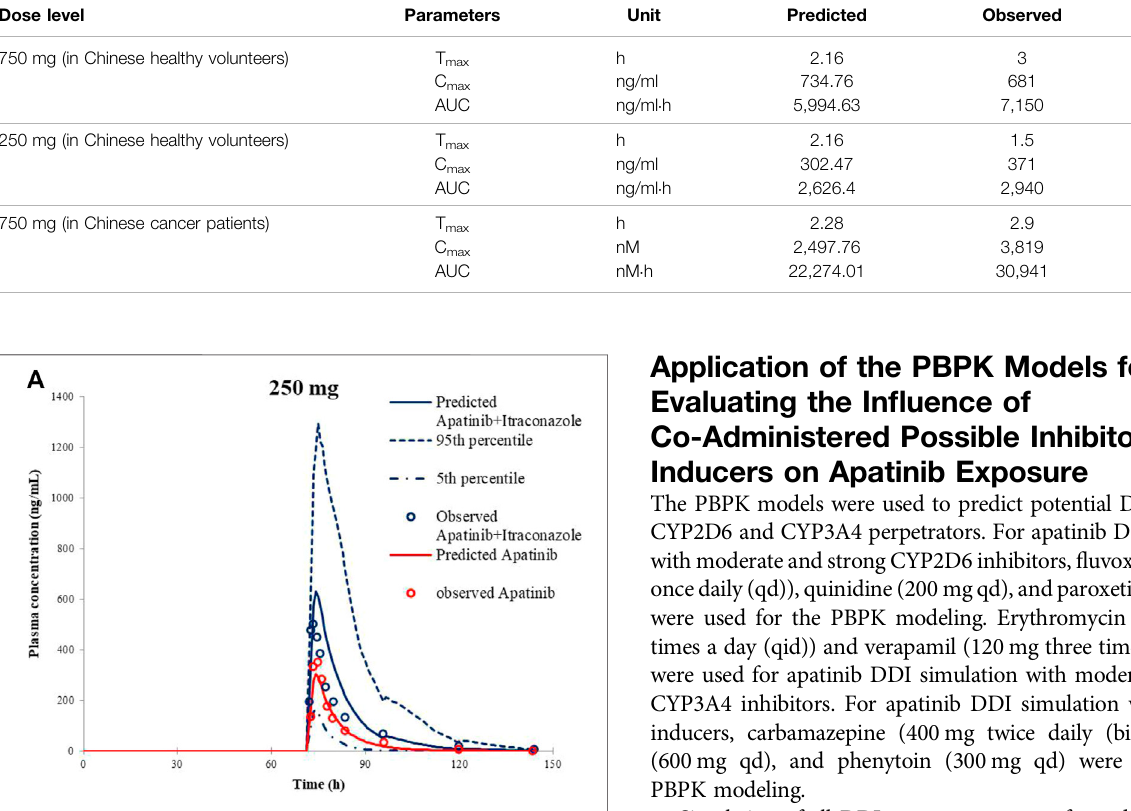
Application of the PBPK Models for